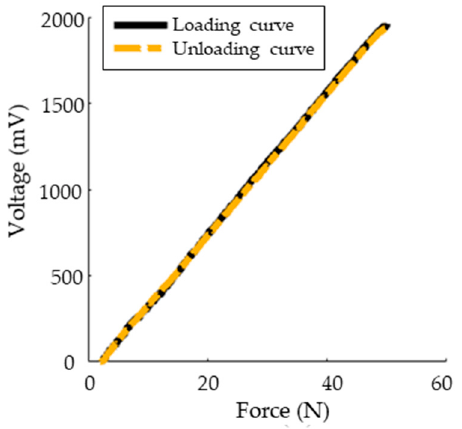
Figure A1. Force–voltage relationship during loading and unloading.